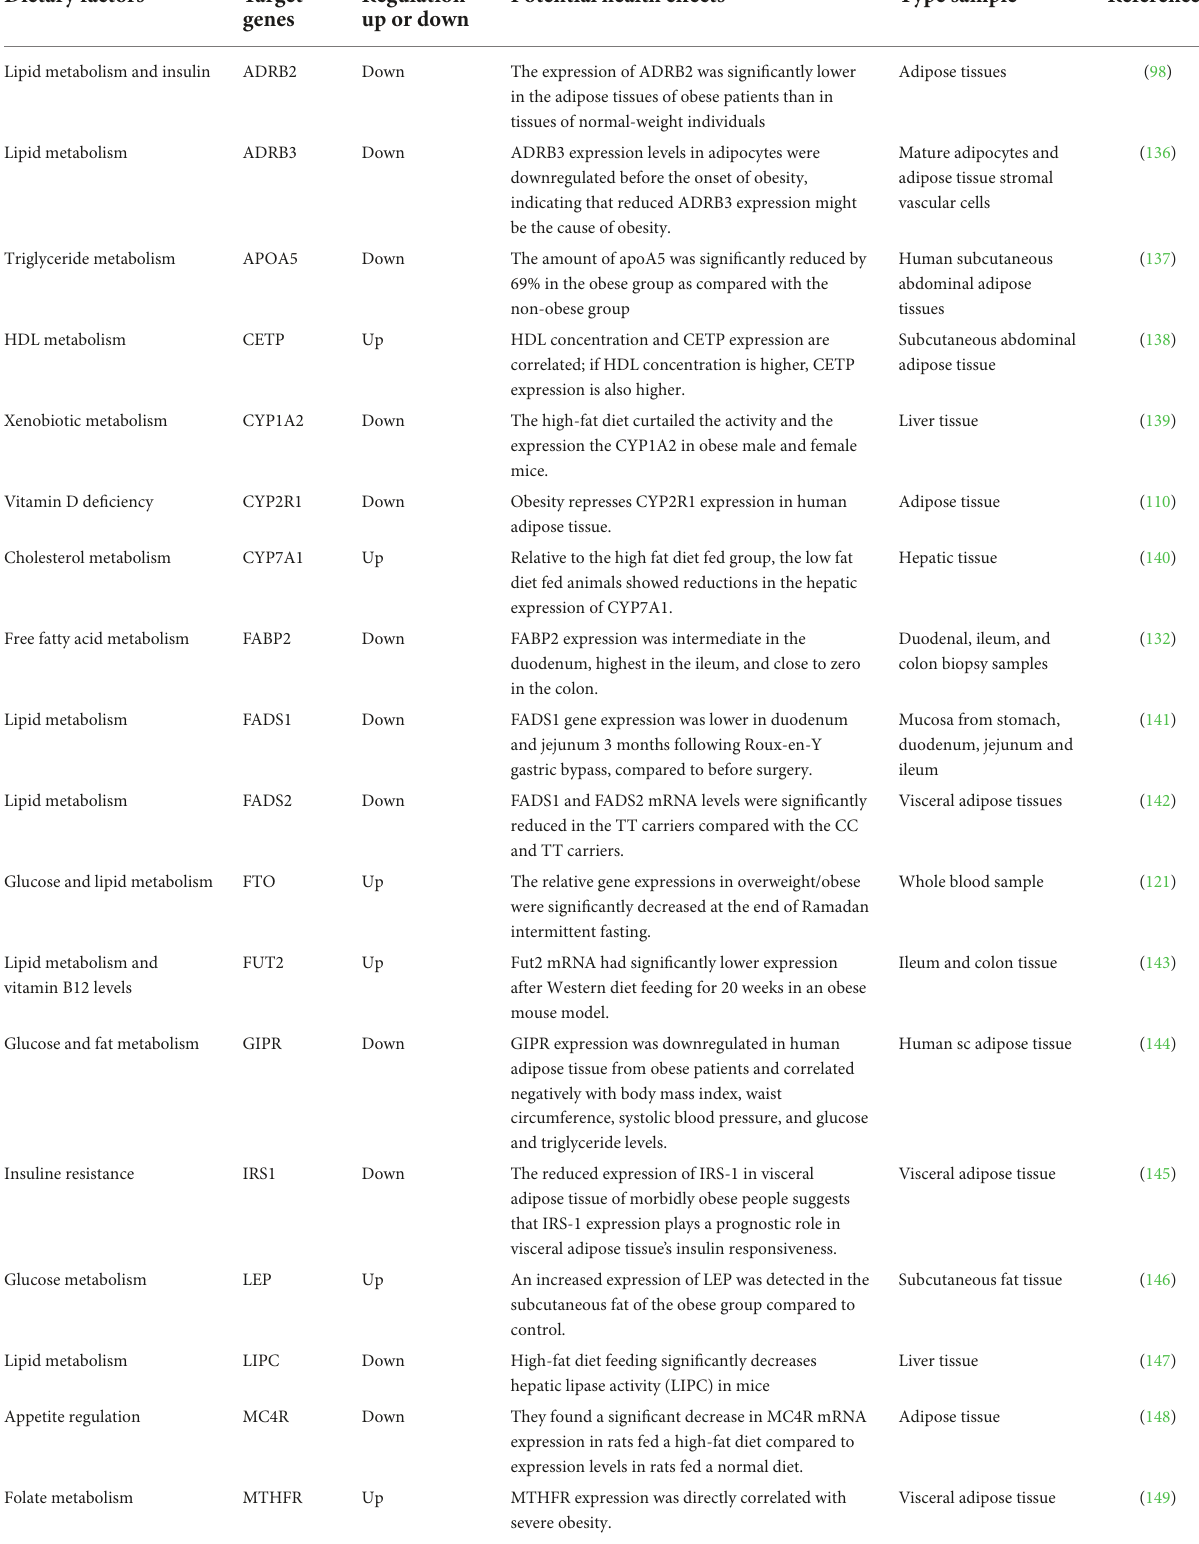
TABLE 2 Influence of dietary factors in gene expression of genes associated with obesity. Dietary